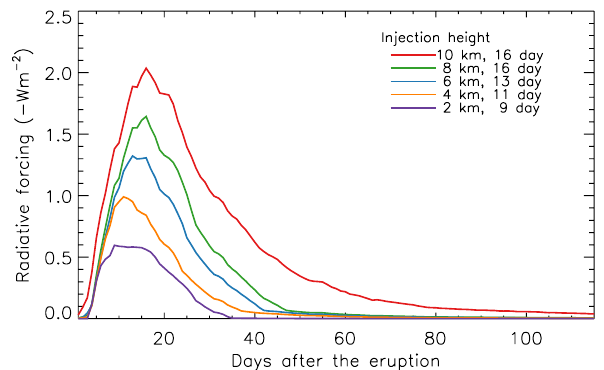
Fig. 9. Temporal evolutions of the daily, global mean volcanic sul- fate radiative forcing (Wm − 2 ) at the top of the atmosphere (TOA) for 5 different volcanic SO 2 injection heights ranging from 10km (shown in red line) to 2km (shown in purple) with interval of 2km (see legend on the top right for details). Also shown in the legend, corresponding to each injection height used in the GEOS-Chem simulation, are days (after the eruption on 8 August 2008) when the peak of the shortwave forcing